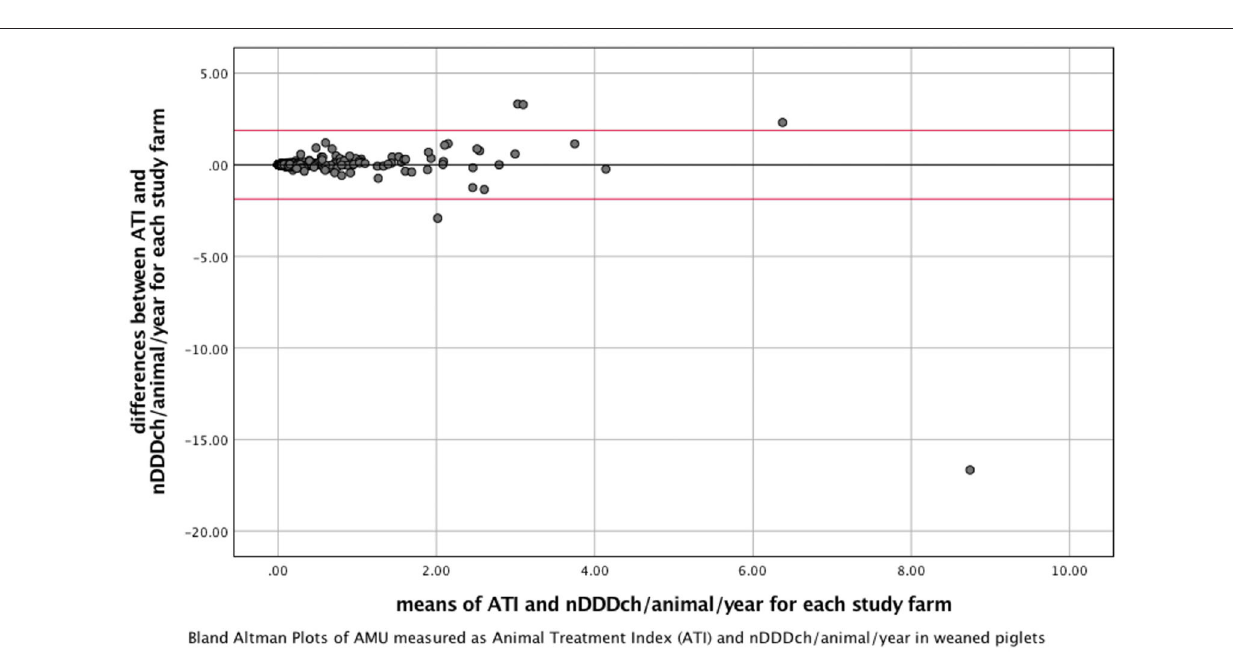
FIGURE 3 | Bland-Altman Plots visualizing interrater reliability of the indicators Animal Treatment Index (ATI) and number of DDDch (nDDDch)/animal/year for 360 farms housing weaned piglets. X-Axis: means of ATI and nDDDch/animal/year; Y-axis: differences between ATI and nDDDch/animal/year. Red lines: ± 1.96 * standard deviation of the datasets calculated from the differences between ATI and